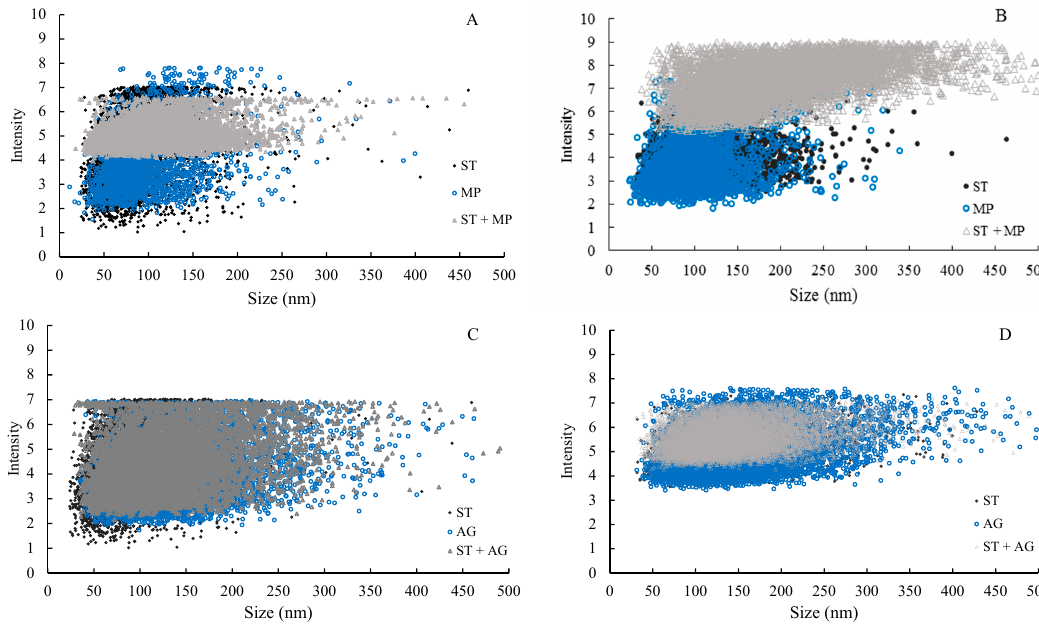
Figure 5. Size vs. light scattering intensity (arbitrary unit) for each tracked particle in nanoparticle tracking analysis. Only 1/5 of all tracked particles were included in the figures for clarity. ( A ) 1.25 mg/mL ST and 0.5 mg/mL MP in 12% ethanol model wine; ( B ) 5 mg/mL ST and 0.5 g/mL MP in 15% ethanol model wine; ( C ) 1.25 mg/mL ST and 0.5 mg/mL AG in 12% ethanol model wine; and ( D ) 5 mg/mL ST and 0.5 mg/mL AG in 15% ethanol model wine. ST solutions containing 1.25 mg/mL or 5 mg/mL respectively were diluted 1:10 or 1:40 with the corresponding model wine prior to analysis.